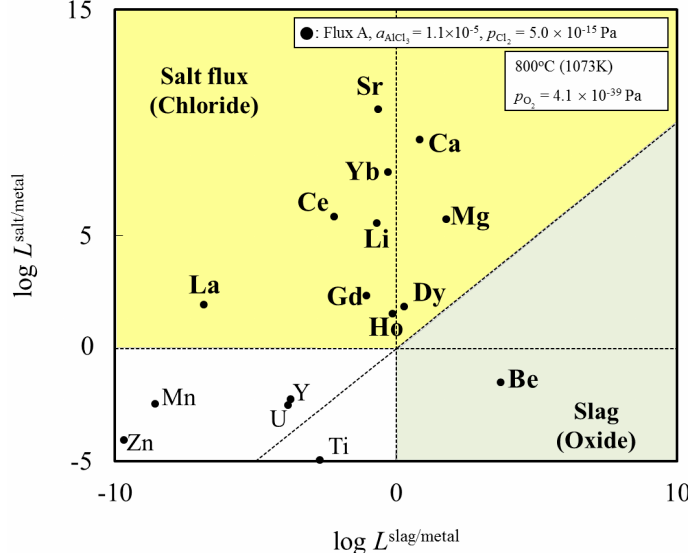
Figure 2. Enlarged section near the origin, taken from Figure 1, showing the distribution of elements among slag (oxide), salt flux (chloride), and metal phases under the simulated atmosphere of the aluminum melting